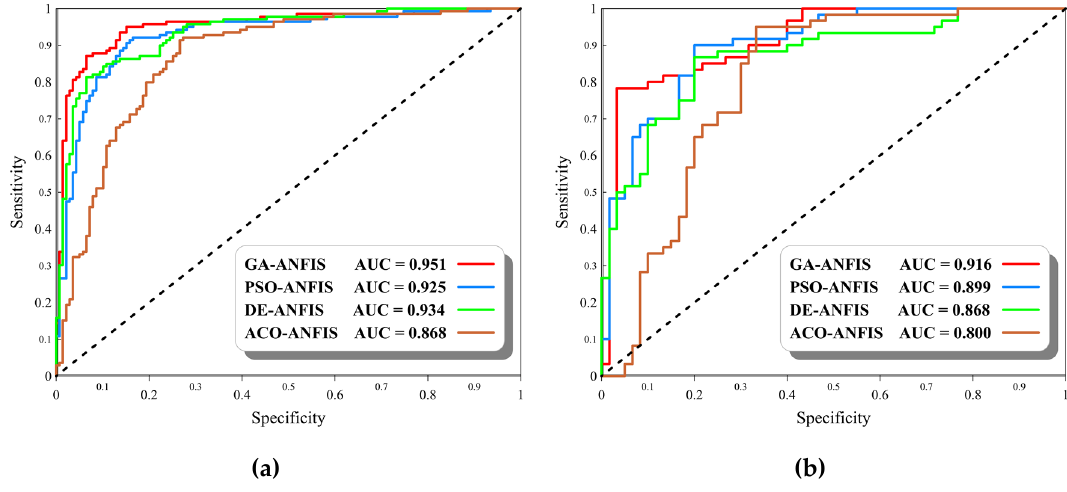
Figure 8. obtained for the (a) training data and (b) testing data. Figure 8. Obtained for the ( a ) training data and ( b ) testing